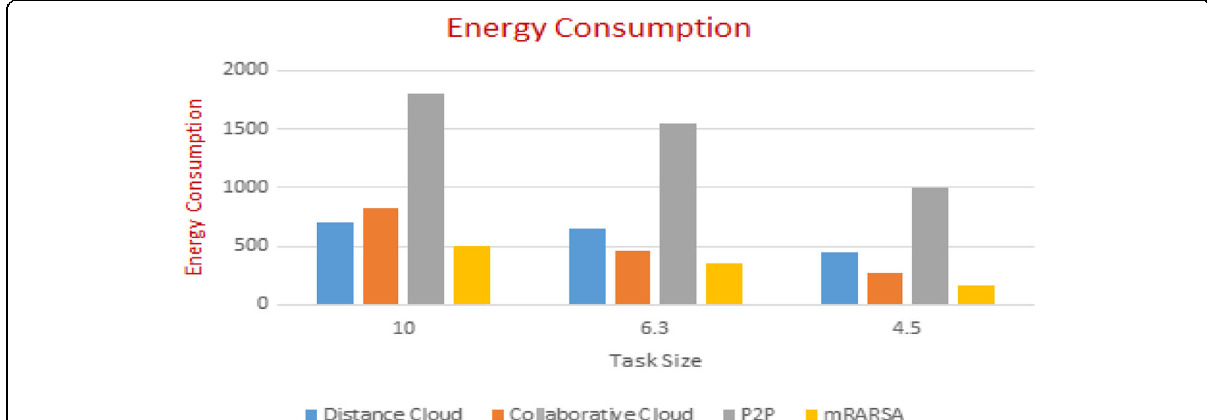
Fig. 13 Energy consumption performance evaluation graph. This graph represents the energy consumption performance against the utilization of the running cloud resources for second resource demanding Eight-Queen problem